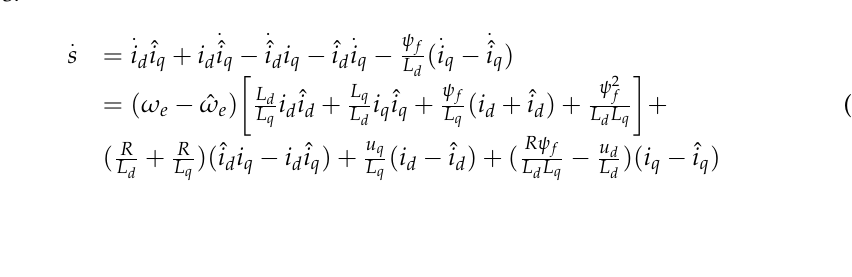
Figure 6. Simulation model of MRAS control system based on stator current.